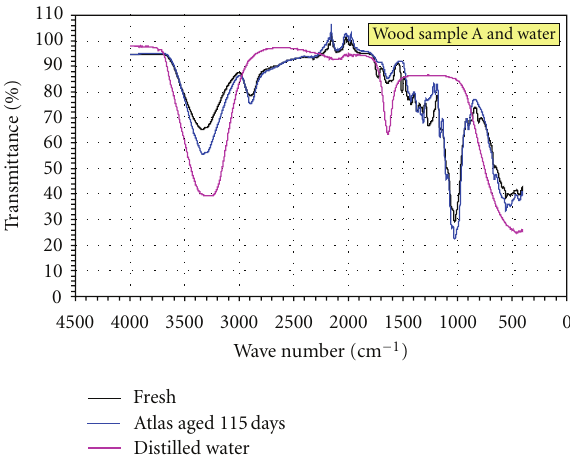
Figure 5: Absorbance (logarithmic) versus wave number between 1900–700 cm − 1 for wood sample A during accelerated ageing in an Atlas Solar Simulator.